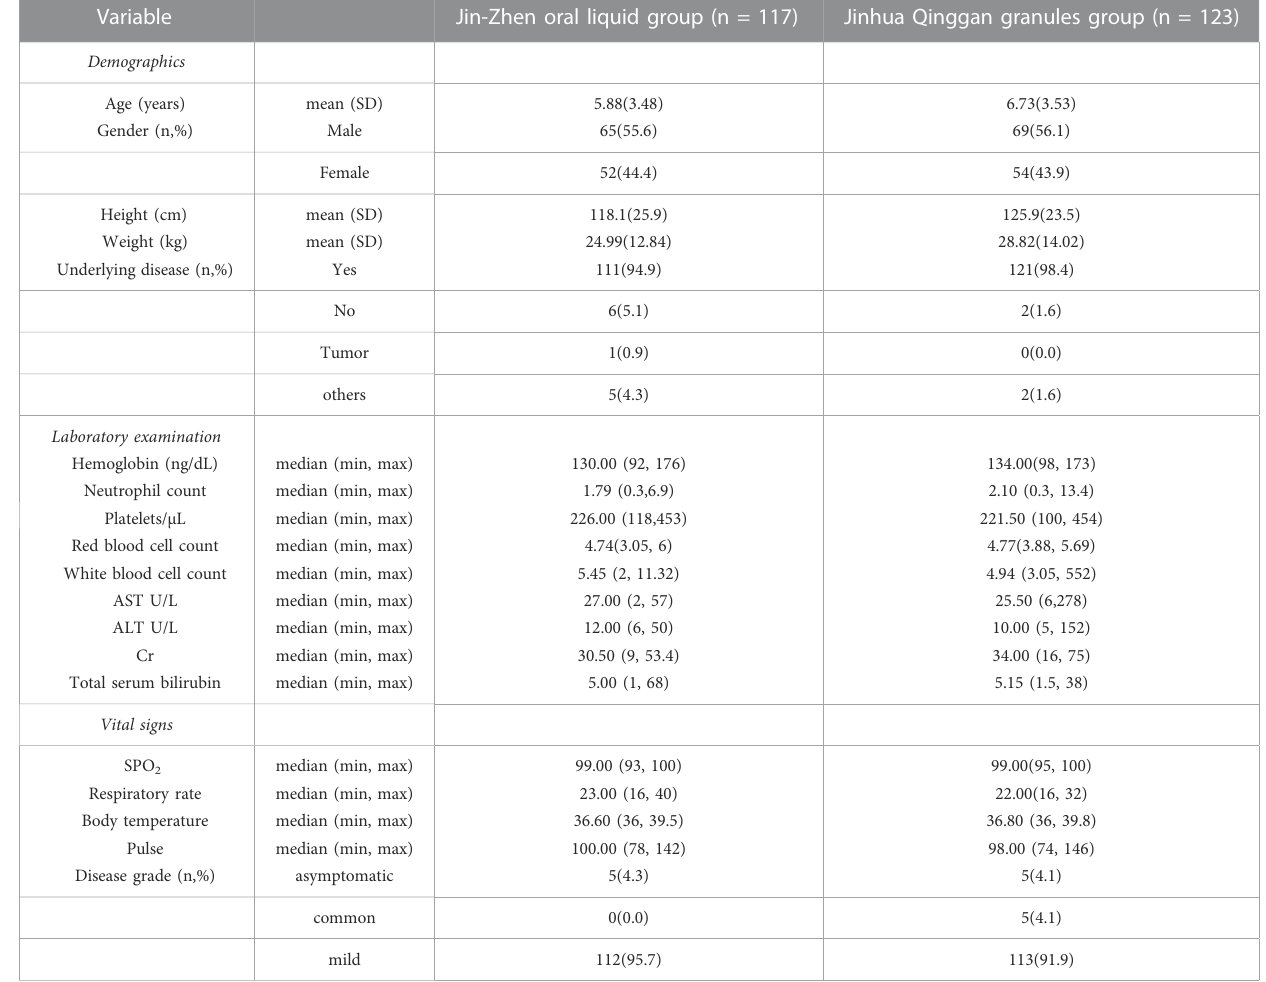
TABLE 1 Demographics and baseline characteristics of the subjects in the trial (FAS).